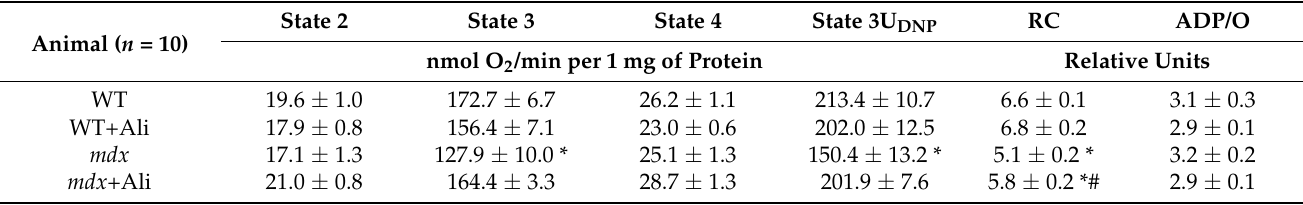
Figure 8. The effect of alisporivir on lipid peroxidation in mitochondria. Lipid peroxidation was assessed by the level of TBARS in the skeletal-muscle mitochondria of experimental groups of animals. The data are presented as means ± SEM ( n = 4).